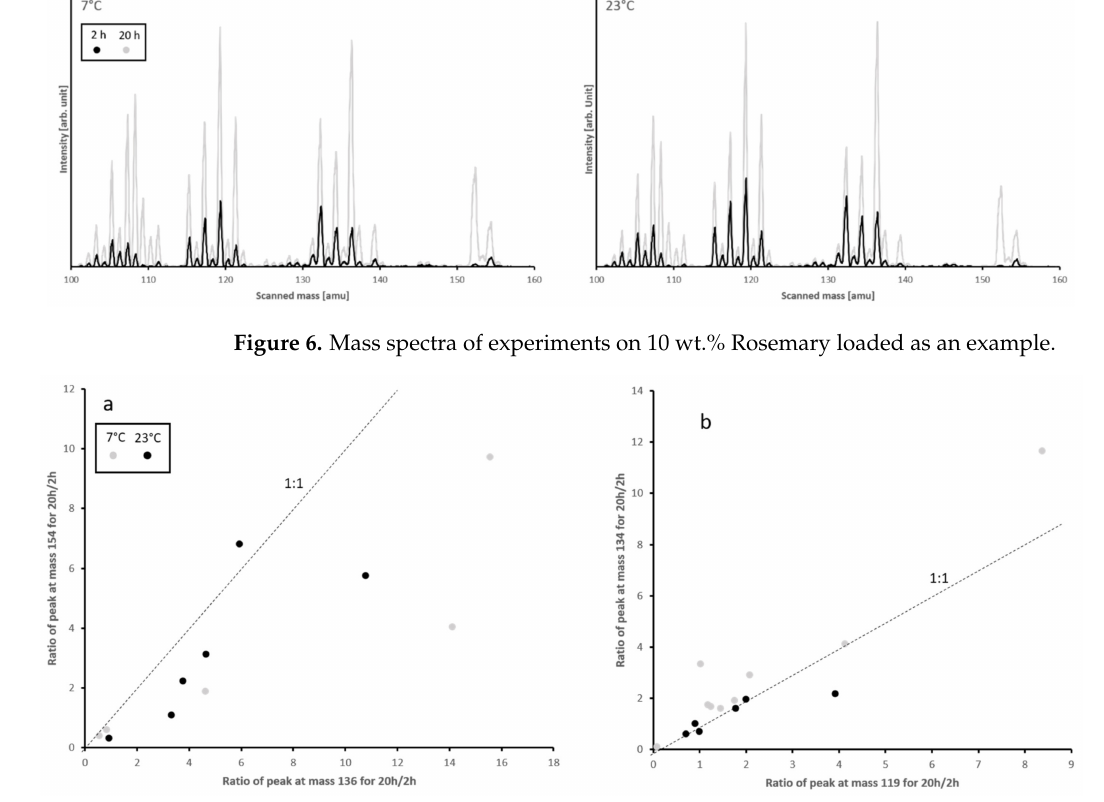
Figure 7. Ratios of mass spectroscopic intensity ratios for the time evolution of the peaks with the highest intensity of Thyme oil ( a ) and Rosemary oil ( b ) loaded